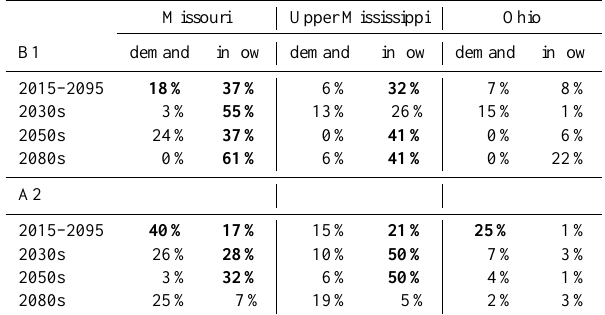
Table 4. Covariances of supply deficit with inflow and water de- mand. Bold values are significant at the 90% confidence level.